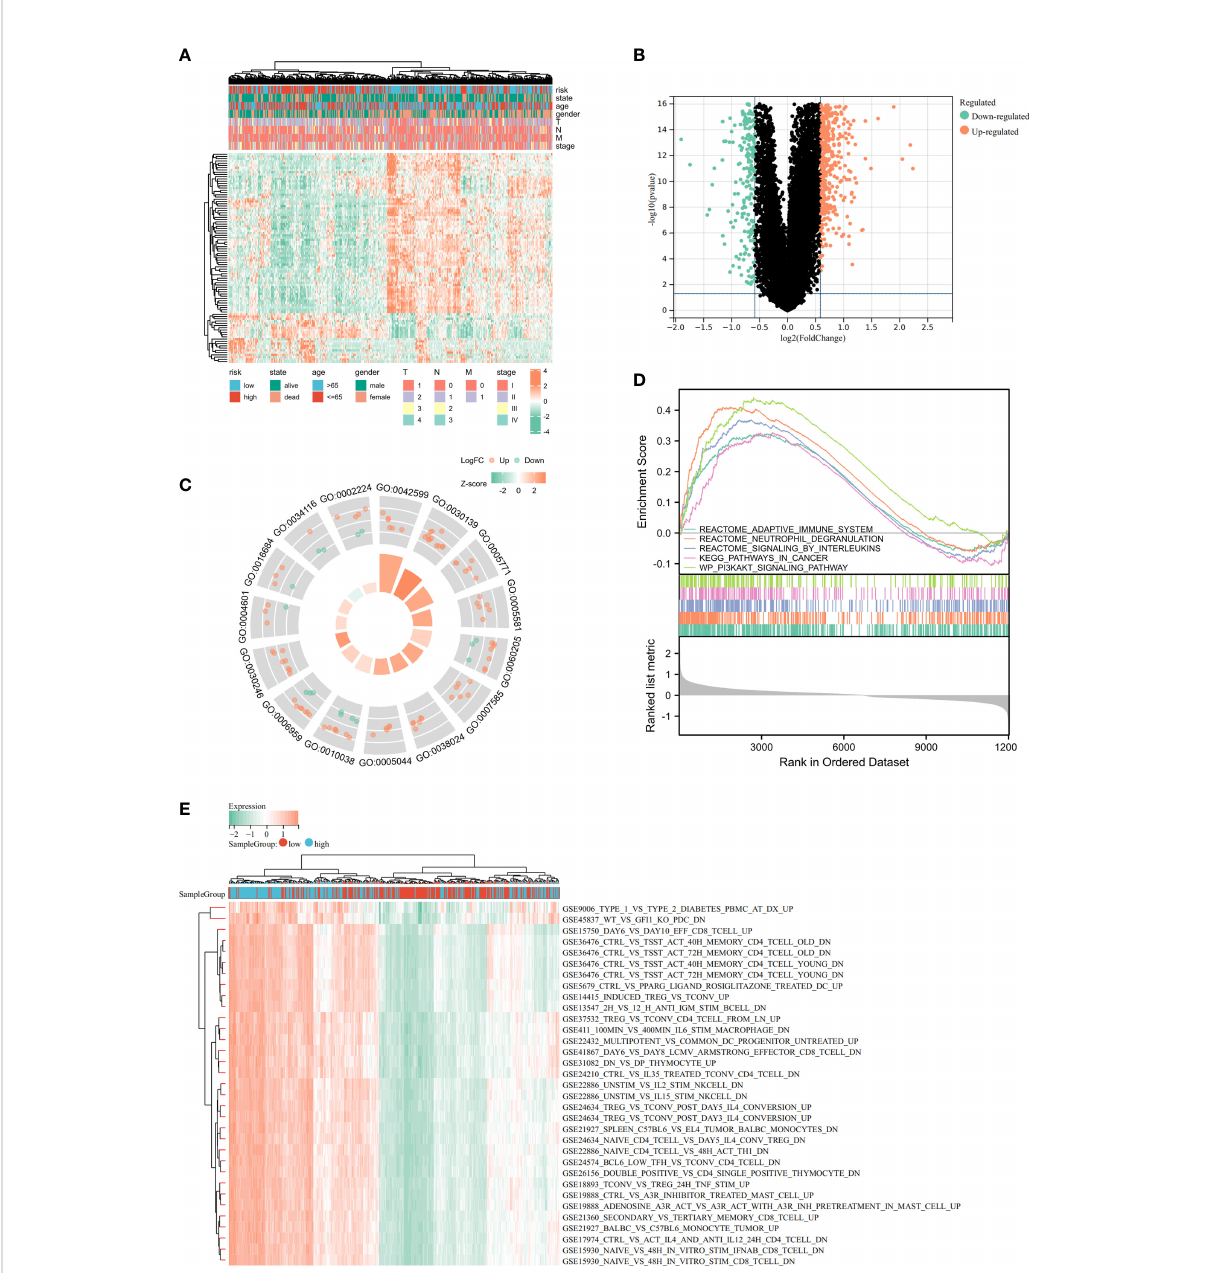
FIGURE 8 Identi fi cation of differentially expressed genes (DEGs) and potential signaling pathways in different isoforms. The heatmap (A) and volcano plot (B) of the differential gene expression between high and low expressed cuproptosis-related signature in LUAD. GO enrichment (C) and GSEA (D) analysis of the differential expressed genes. (E) GSVA enrichment analysis of the differential